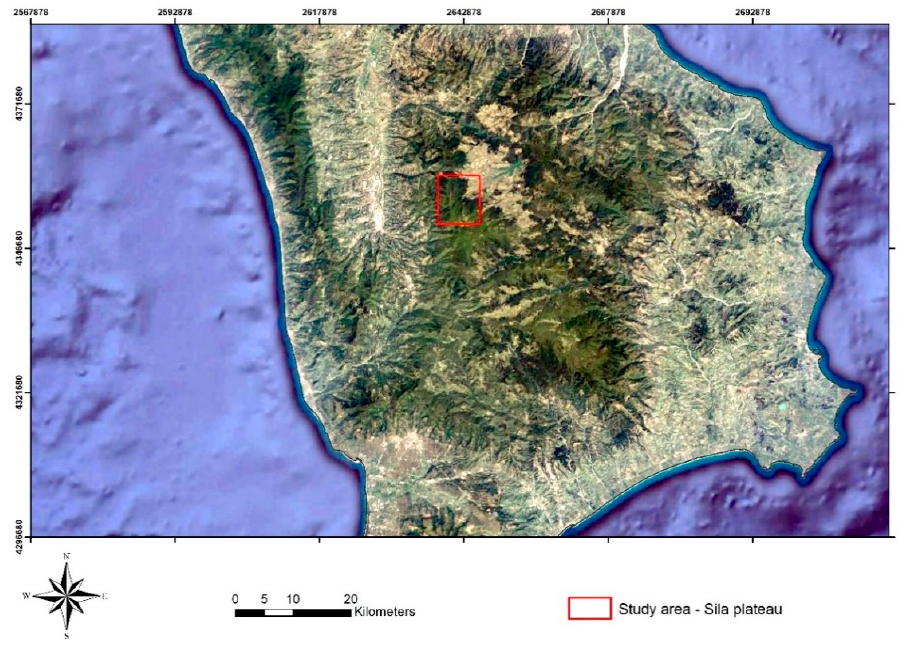
Figure 1. The study area (in red) of the Sila plateau in Calabria (Southern Italy) (EPSG 3004).